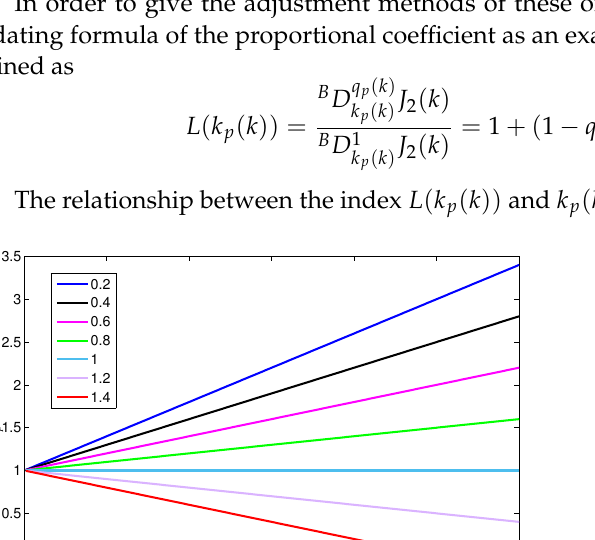
Figure 4. Curves of L ( k p ( k )) with different orders q k